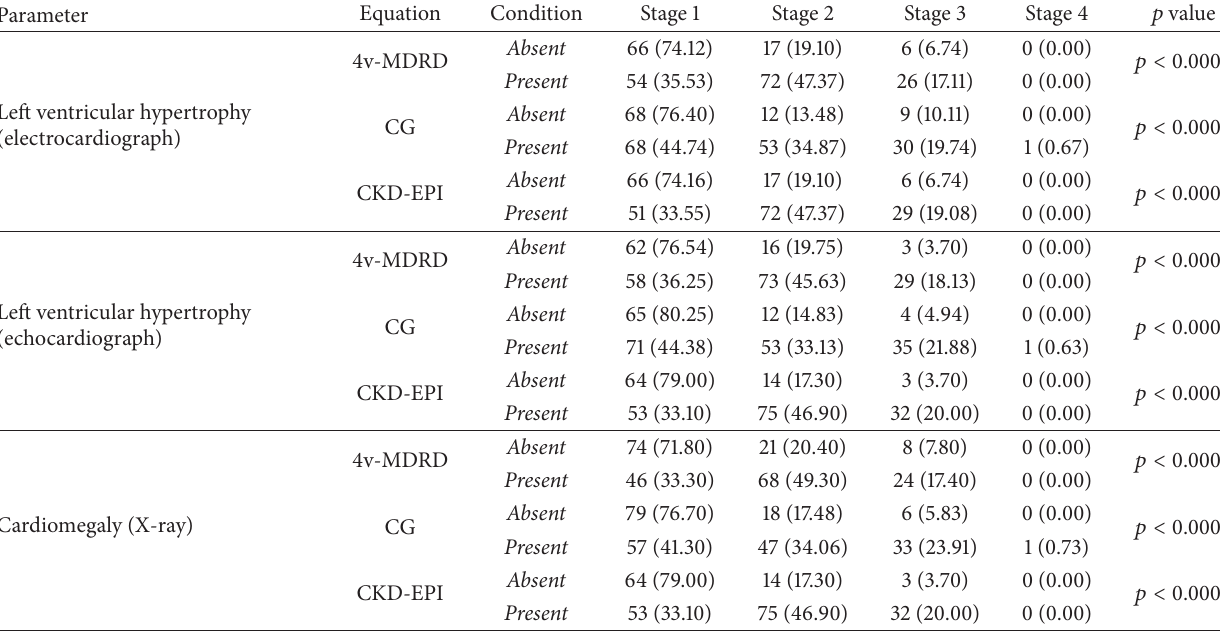
Table 6: Staged renal insufficiency stratified by the presence of clinical manifestation of cardiac disorder (nonspecific sinuses, left ventricular hypertrophy, and heart